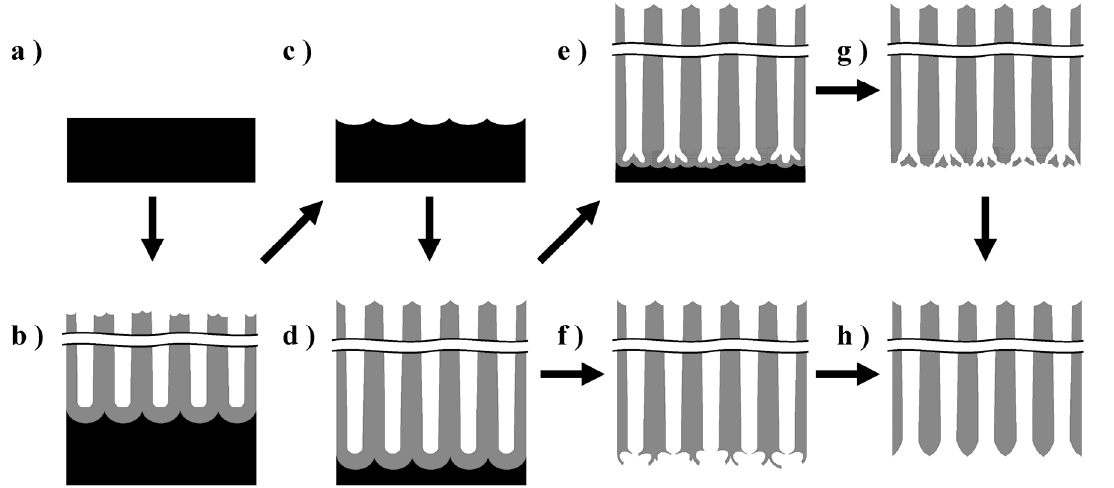
Figure 11. Schematic of the fabrication process of anodic porous alumina membranes ( a ) Electropolishing; ( b ) First anodizing step; ( c ) Removal of anodic film; ( d ) Second anodizing step; ( e ) Barrier layer thickness reduction for the films formed at voltages higher than 100 V using a stepwise voltage reduction; ( f ) and ( g ) Detachment of the anodic film; ( h ) Chemical etching in 5 wt% phosphoric acid at 30